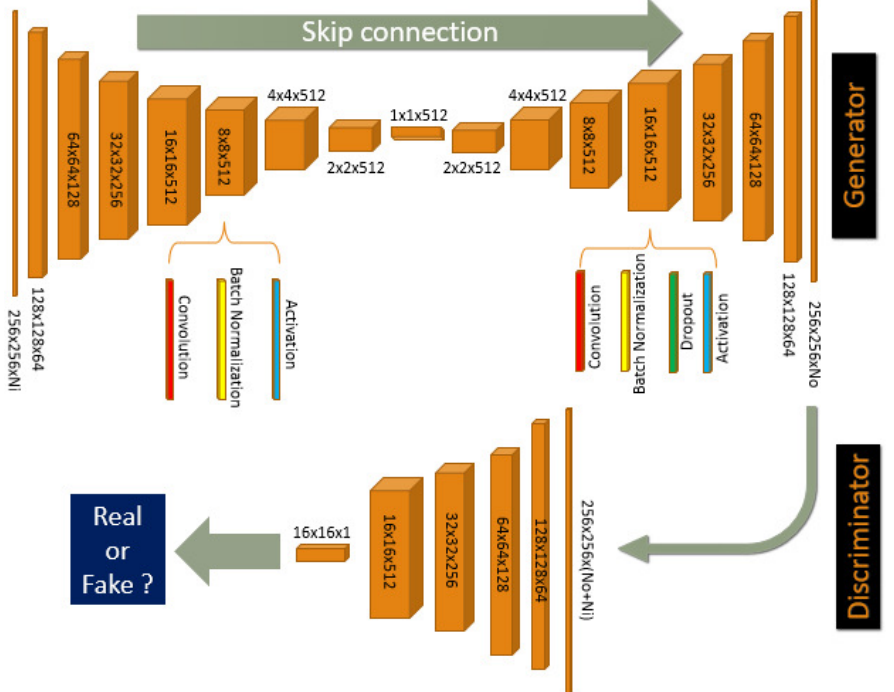
Figure 2. Our pix2pix-CGAN architecture. Encoder blocks CEk are from first block 256 × 256 × N i to bottleneck block 1 × 1 × 512 of Generator. Decoder blocks CDk are from bottleneck block 1 × 1 × 512 to last block 256 × 256 × N o of Generator. N i , N o denote the number of input and output image channels of Generator. Discriminator blocks Ck are from block 256 × 256 × ( N i + N o ) to block 16 × 16 × 1. Because of the skip connection, the total channels that pass to Discriminator is N i + N o . Best viewed in